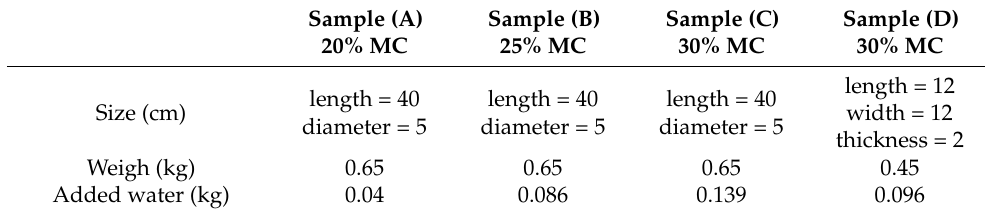
Table 1. Details of the physical sizes of the samples.